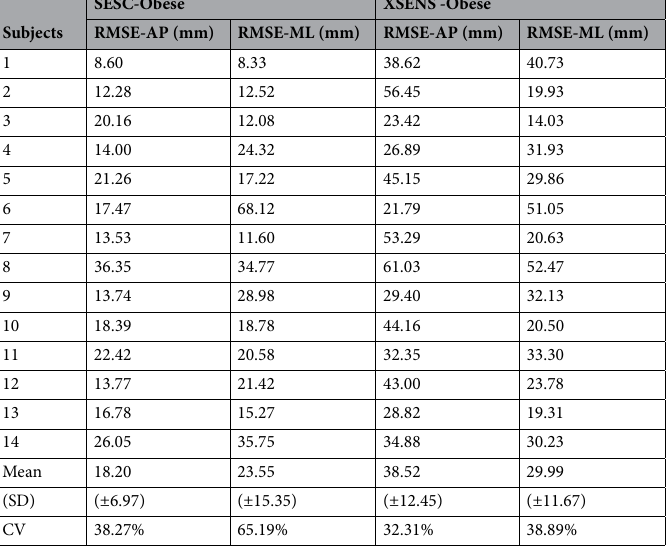
Table 2. The RMSEs of the CoM estimations based on SESC and segmental (XSENS) method for 14 Obese subjects along AP and ML axes. The mean and standard deviation (SD) values of the RMSEs of the subjects and the coefficients of variation (CV) are provided in the last three rows.